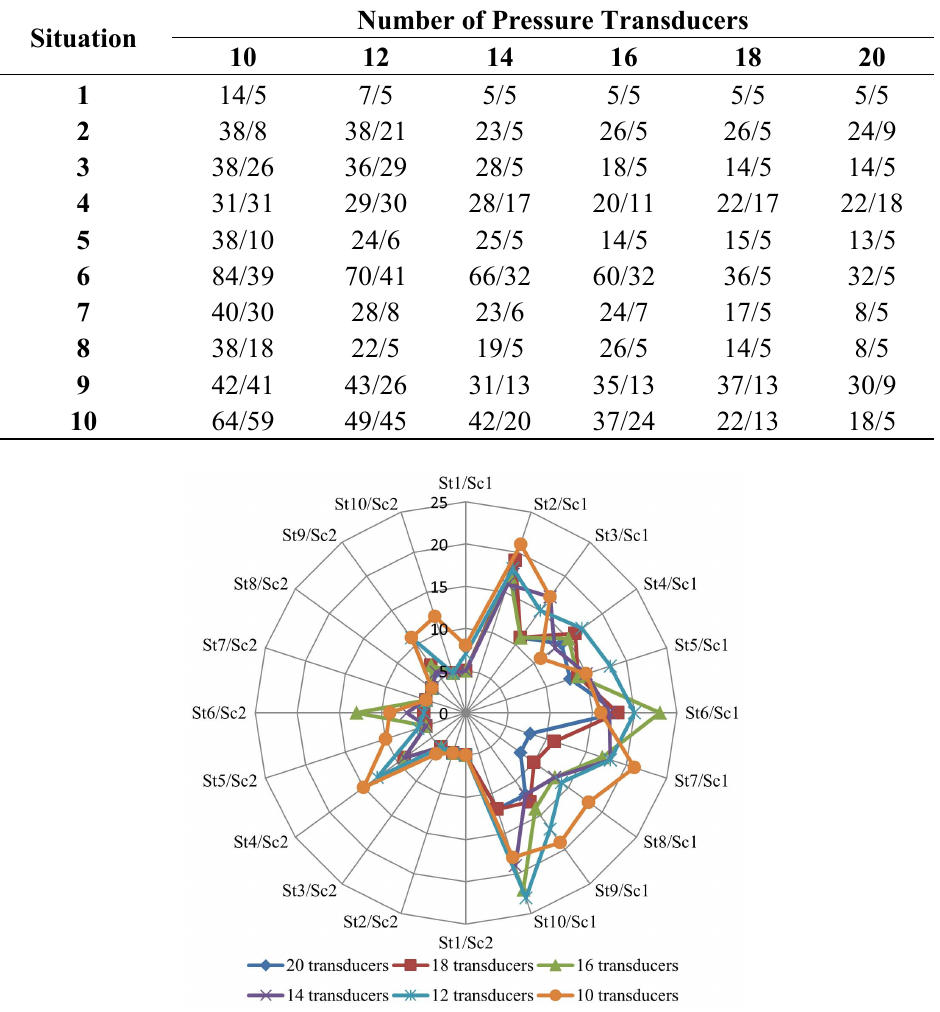
Table 7. Number of total leaky pipes in the second WDN (scenario 1/scenario 2).